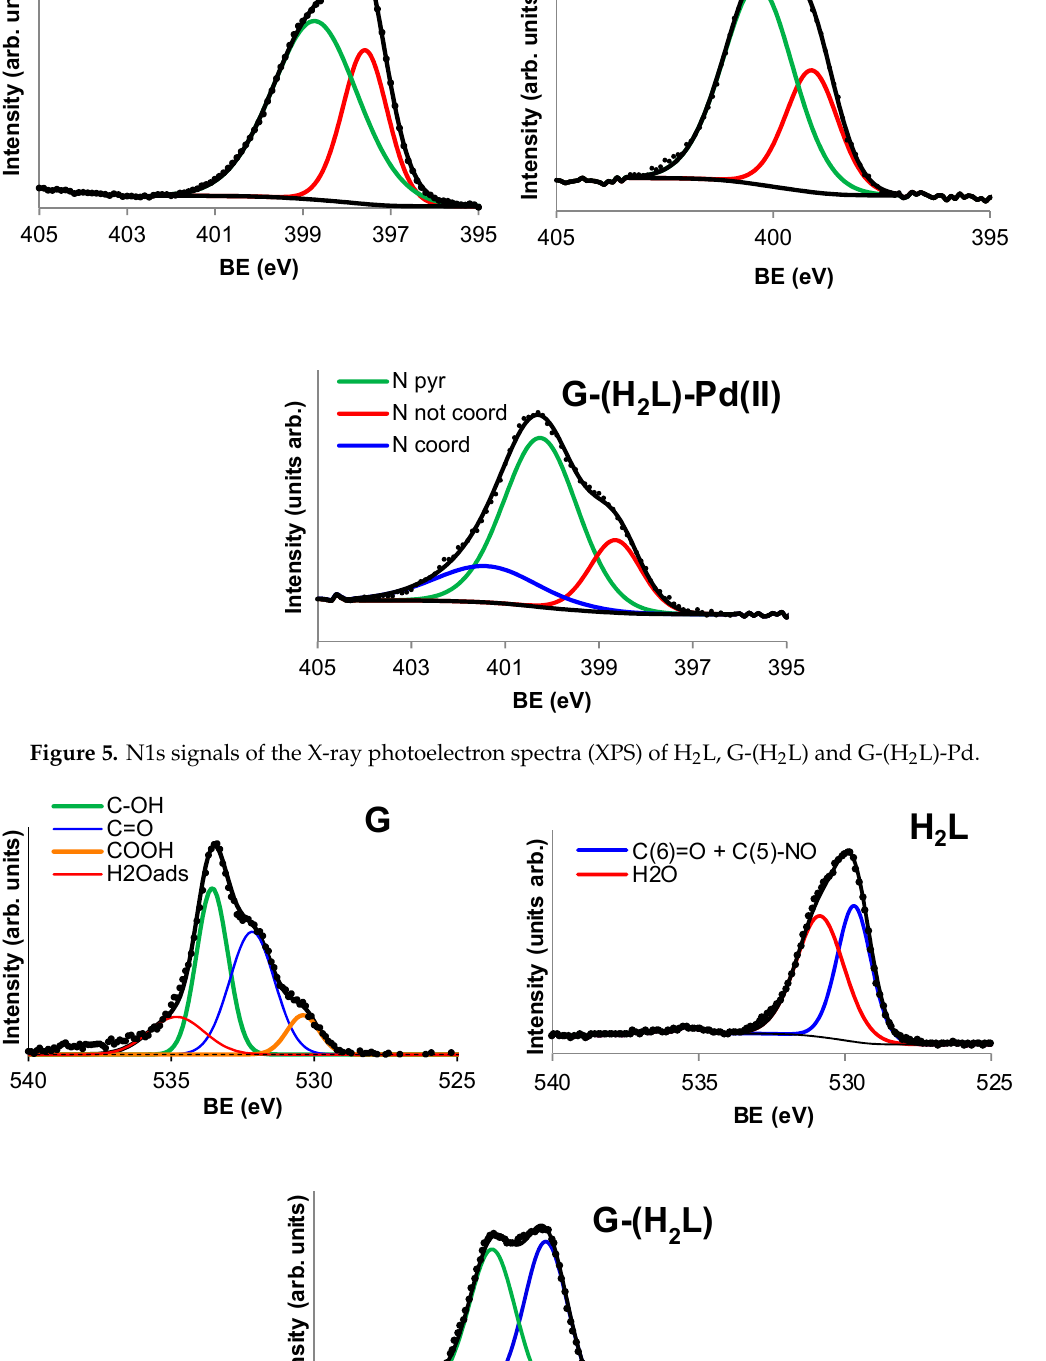
Figure 6. O1s signals of the XPS spectra of G, H 2 L and G-(H 2 L).